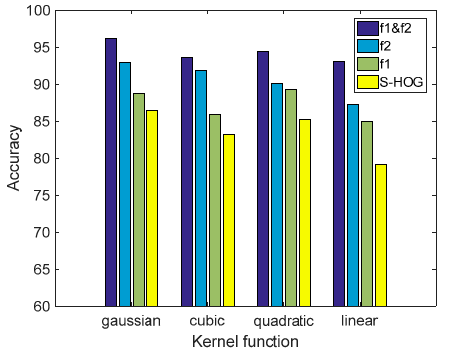
Figure 11. Classification performance of four feature sets with different kernel function.